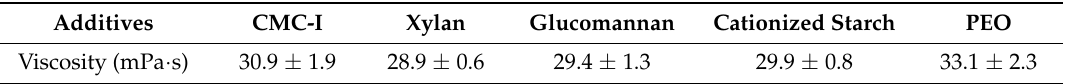
Table 1. Viscosity (mean ± STDEV) of different macromolecules at 0.15 g/L concentration and measured at 250 rpm rotational speed of the rotational viscometer.